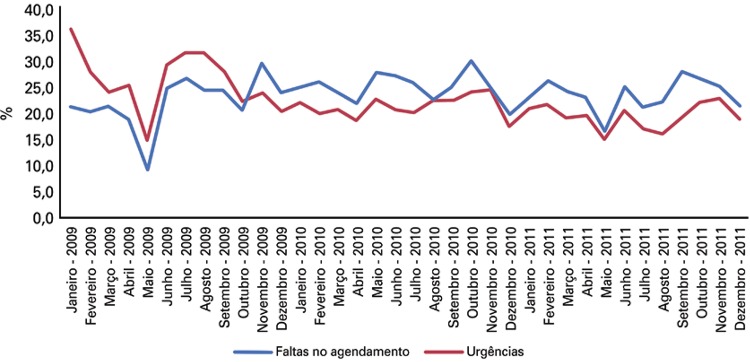
Evolução do percentual de faltas e de urgências, ao longo dos meses, no período 2009-2011